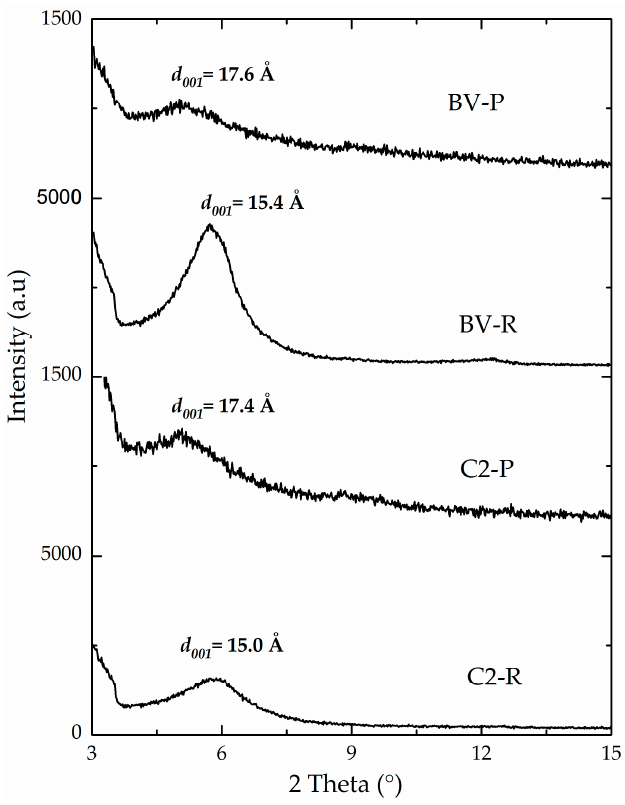
Figure 3. X-ray powder diffraction patterns of refined and pillared materials.